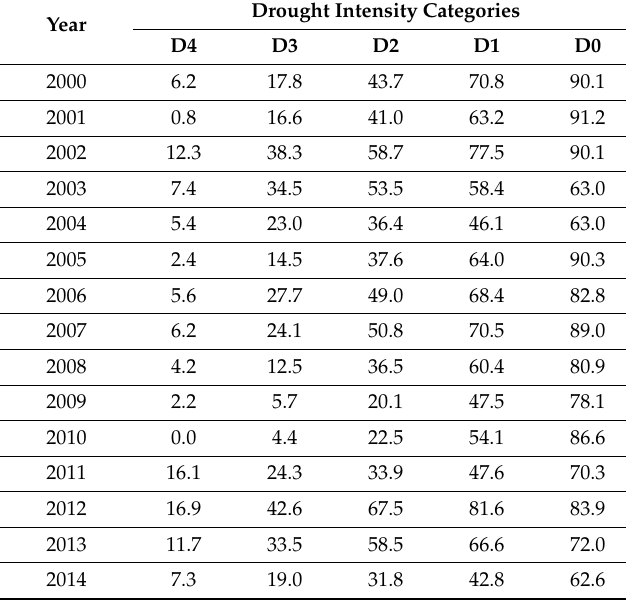
Table 1. The percentage areal coverage of different drought intensity categories in the contiguous